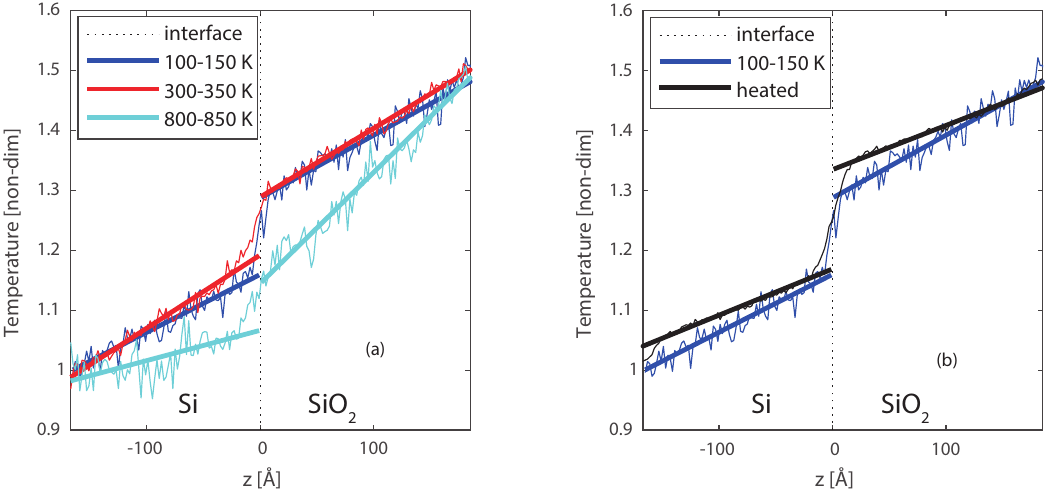
Figure 8. Temperature profiles for the Si/SiO 2 interfaces, with ( a ) case 1, case 2, and case 3, and ( b ) case 1, and case 4. The dotted line indicates the location of the interface, the dark blue lines represent case 1 ( T H = 150 and T C = 100 K), the red lines represent case 2 ( T H = 350 and T C = 300 K), the light blue lines represent case 3( T H = 850 and T C = 800 K), and the black line represents case 4 (first heated to 1700 K, and then a steady state at T H = 150 and T C = 100